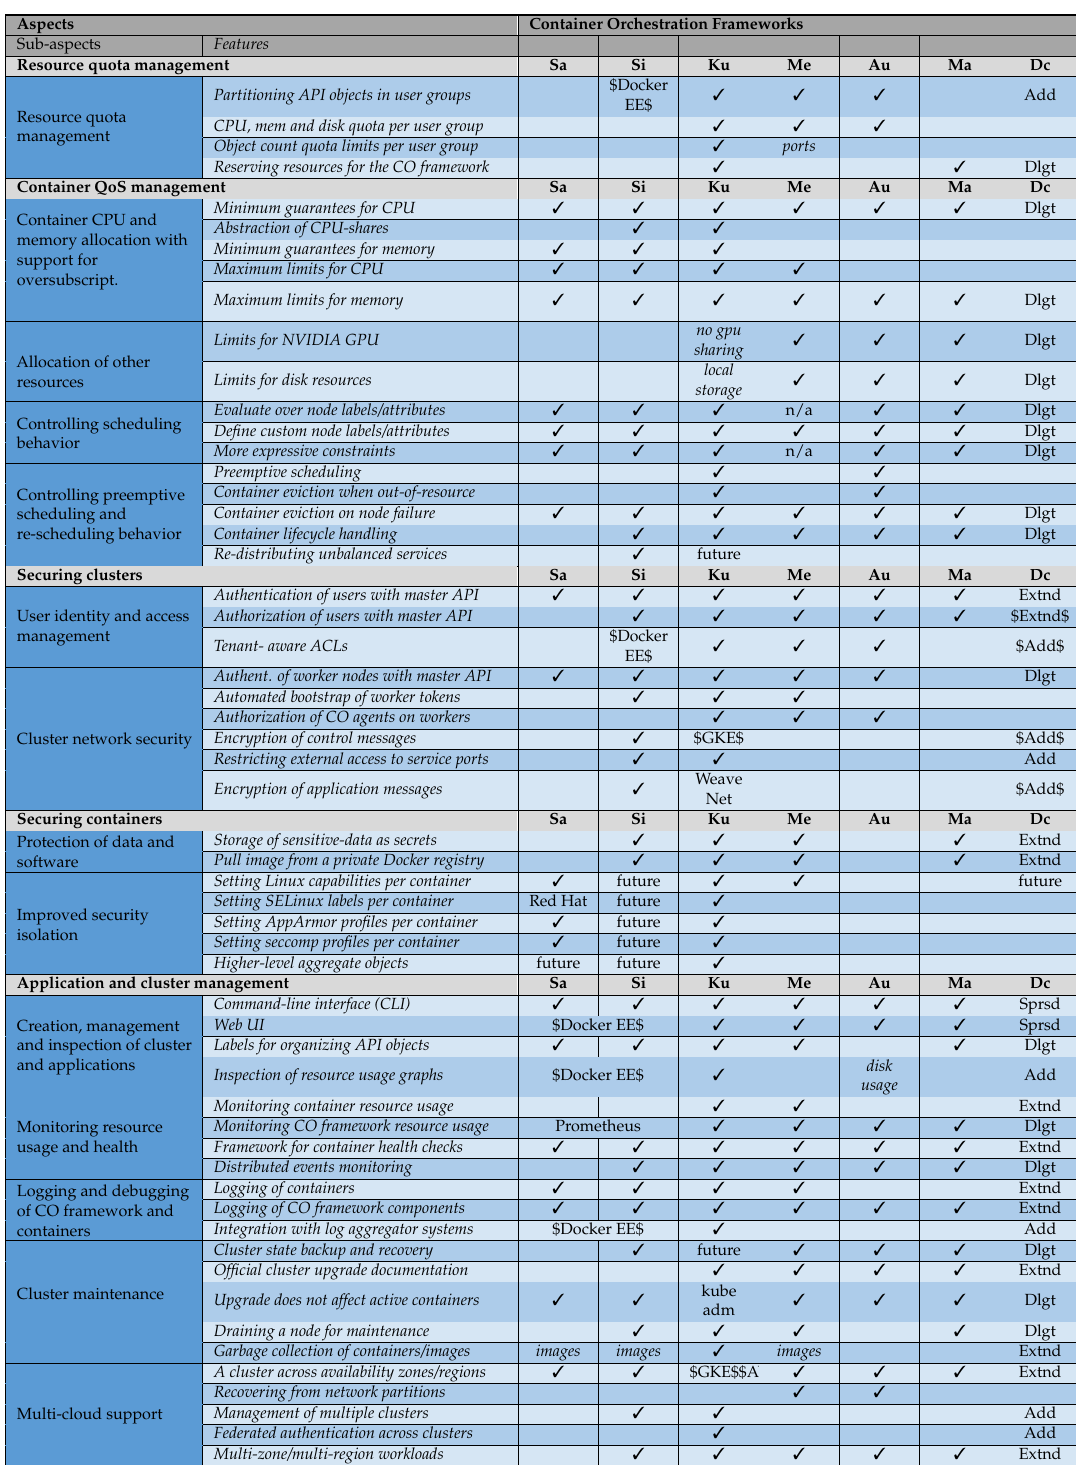
Table 2. Cont . Container Orchestration Frameworks Sa $Docker EE$ Add storage Dlgt